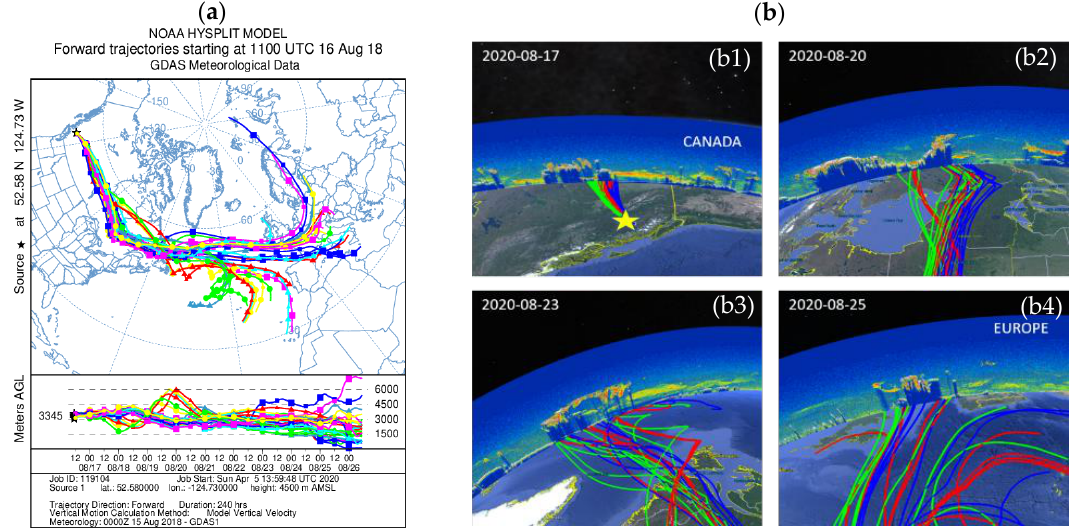
Figure 2. ( a ) 10-day forward ensemble air mass trajectories starting on 16 August (11:00 UTC), as provided by HYSPLIT. Di ff erent color-lines of the forward trajectories correspond to trajectories for all-possible o ff sets in longitude, latitude and altitude according to the ensemble